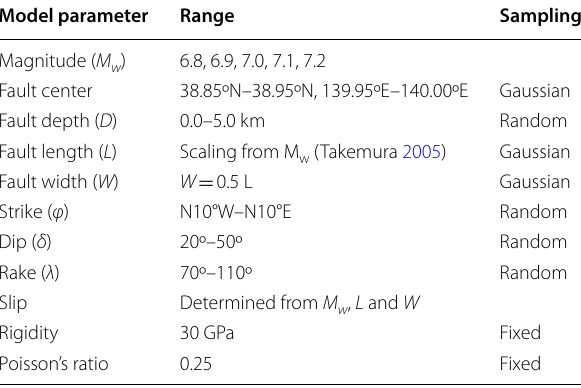
Table 2 Fault parameters of the 1894 Shonai earthquake and its tested ranges and assumed sampling in the